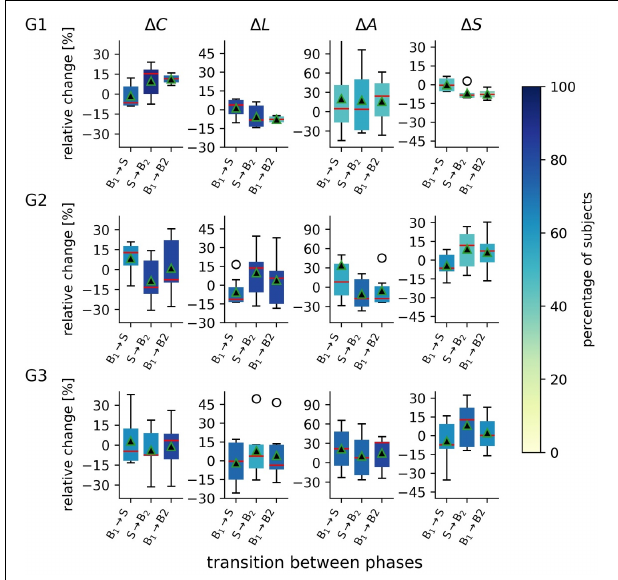
FIGURE 2 | Distributions of taVNS-related alterations in global network characteristics of the three investigated groups (G1 = focal epilepsy group, G2 = generalized epilepsy group, G3 = non-epilepsy group) between the three investigated phases (B1 = pre-stimulation baseline 1, S = stimulation, B2 = post-stimulation baseline 2). Boxplots of relative changes in network characteristics (average clustering coefficient C , average shortest path length L , synchronisability S , and assortativity A ). Bottom and top of a box are the first and third quartiles, and the red band and the black triangle are the median and the mean of the distribution. The ends of the whiskers represent the interquartile range of the data. Outliers are marked by an o-sign. Boxes are color coded according to the percentage of subjects for whom significant changes in global network characteristics were observed on per subject